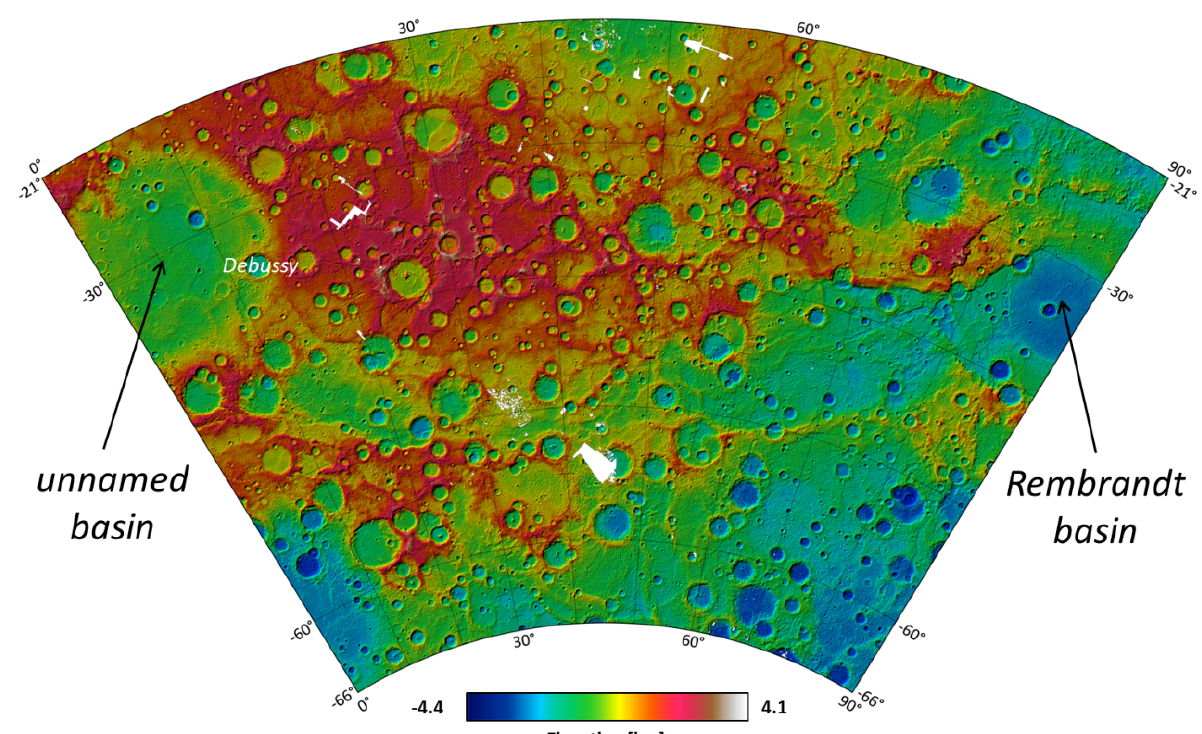
Figure 4: H13 “Neruda” quadrangle DTM.